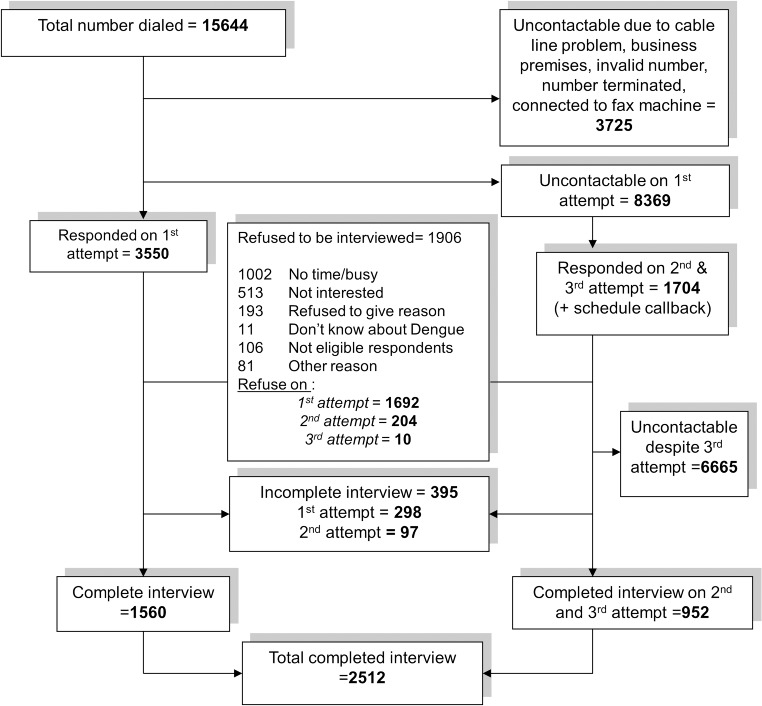
Illustration of the CATI process of the survey.